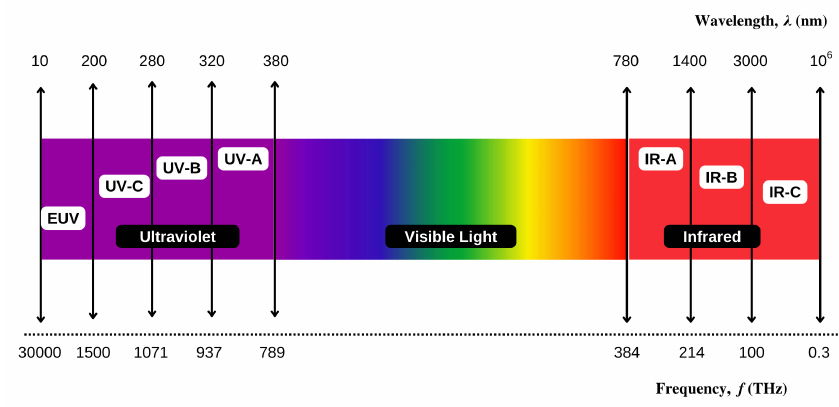
Figure 1. The optical spectrum. Table 1. Surveys on Visible Light